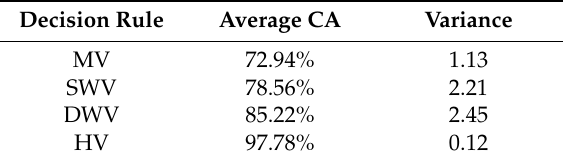
Table 4. Comparison of the accuracy and variance of different decision